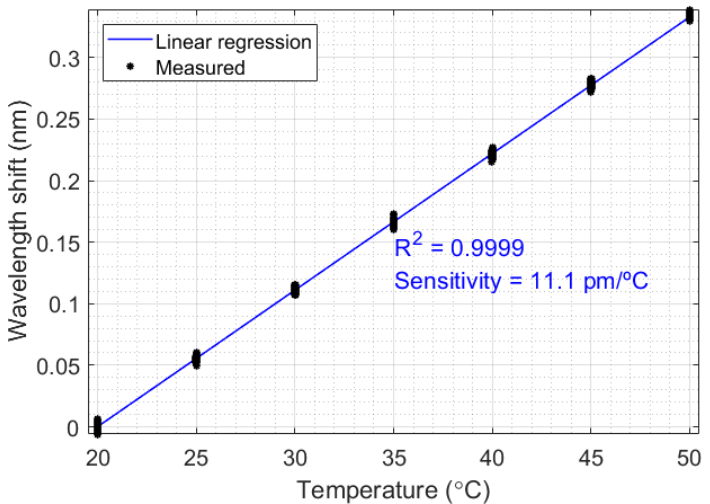
Figure 3. Characterization of the FBG-based temperature